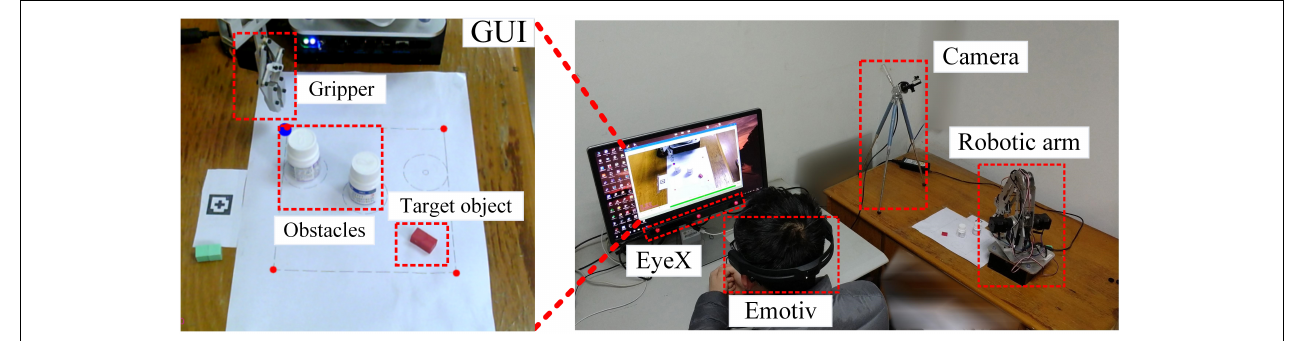
FIGURE 1 | The overview of the experimental